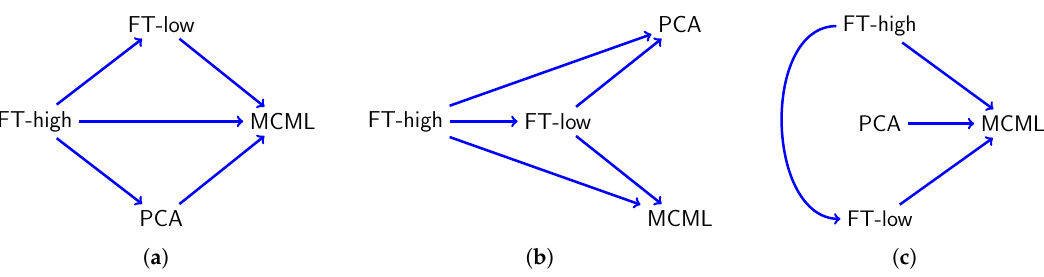
Figure 5. Significant results of paired t-tests for task accuracy. An arrow from condition A to condition B indicates that participants performed significantly more accurately under A than under B. ( a ) All Tasks; ( b ) Clustering; ( c )